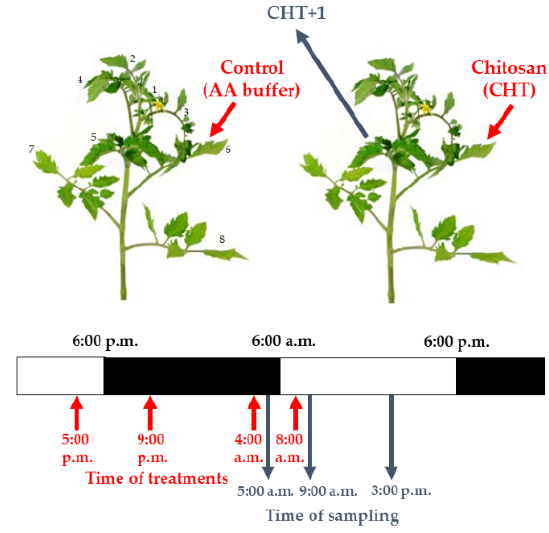
Figure 11. Experimental setup of chitosan (CHT) treatments and time of samplings.